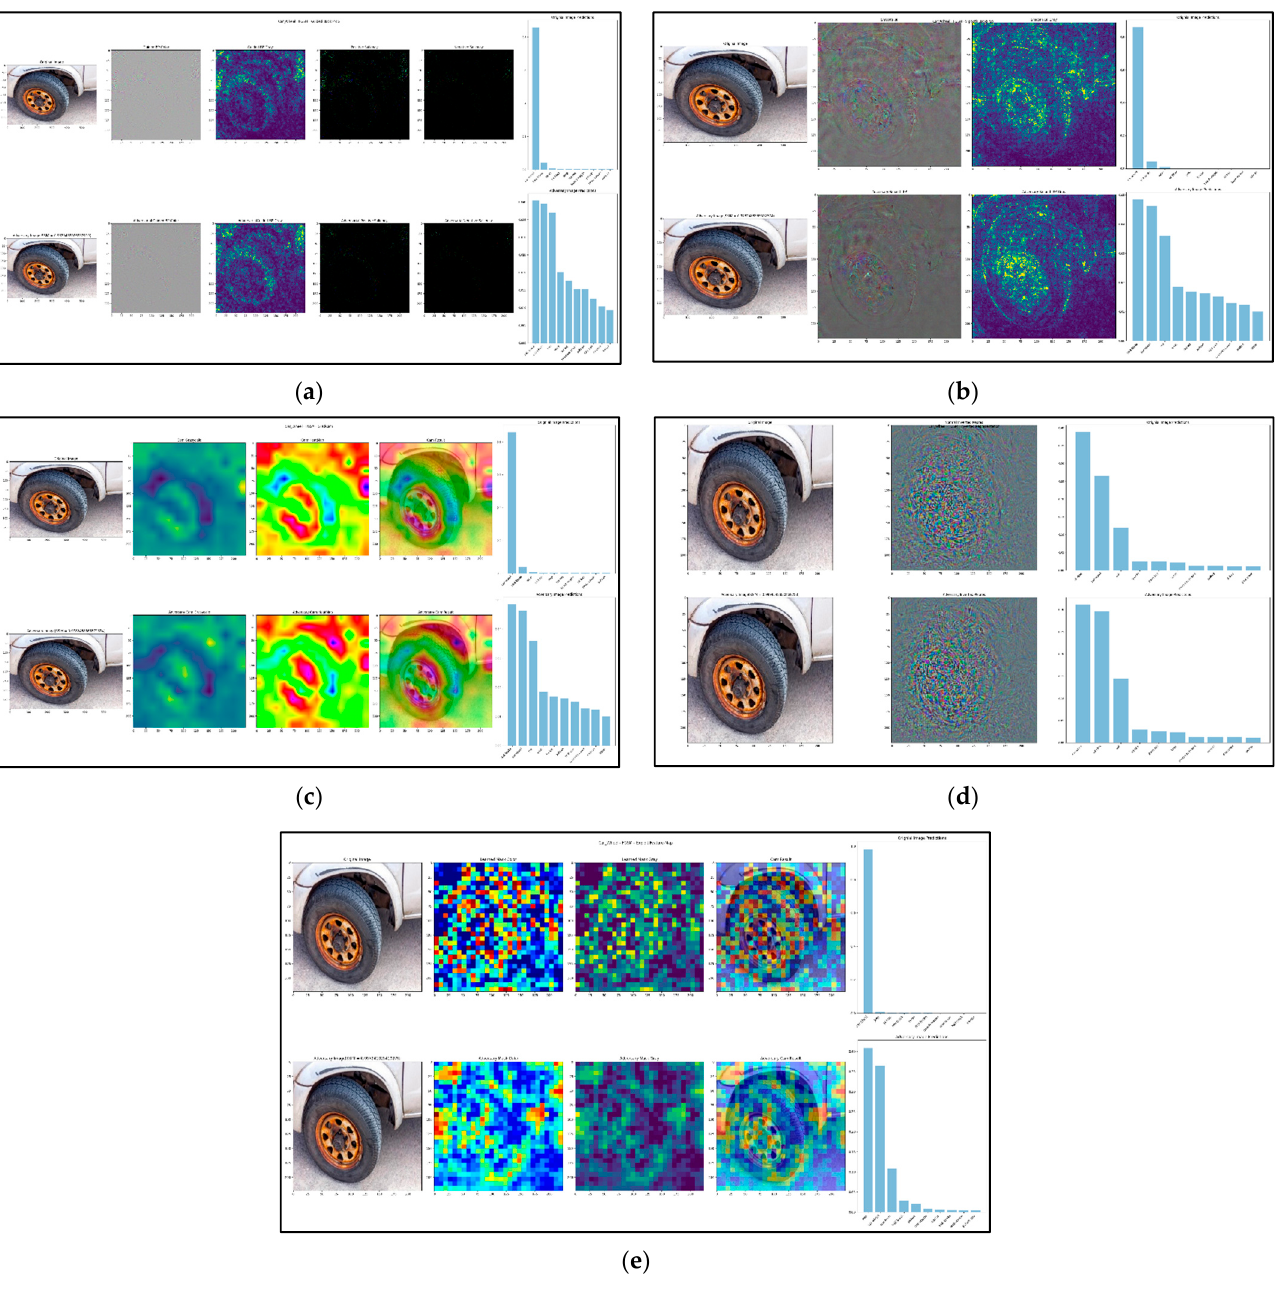
Figure 5. ( a ) Guided propagation model; ( b ) smooth grad; ( c ) guided class activated mapping; ( d ) inverted gradient; and ( e ) novel exploit feature-map.